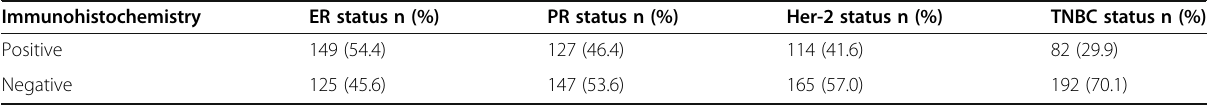
Table 2 Breast cancer tumor immunohistochemistry ( n =